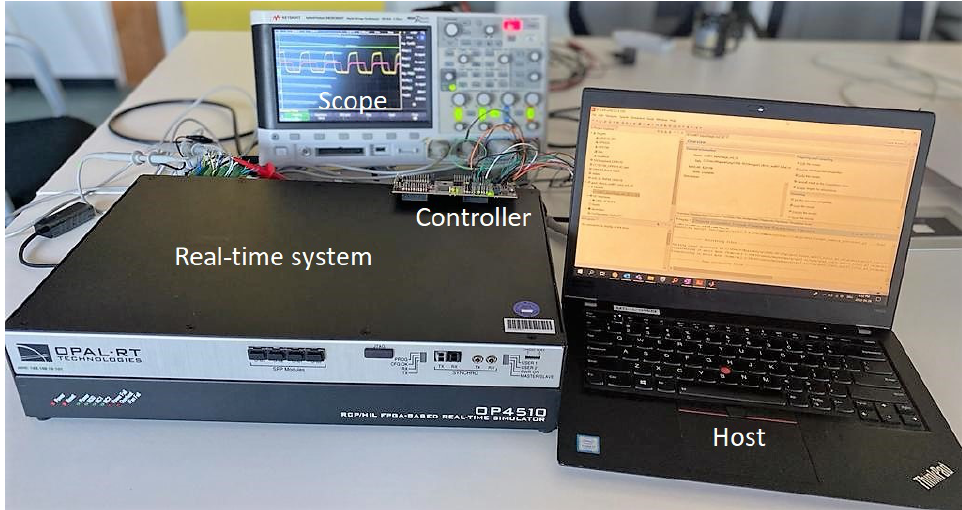
Figure 22. Experimental setup with OP4510.